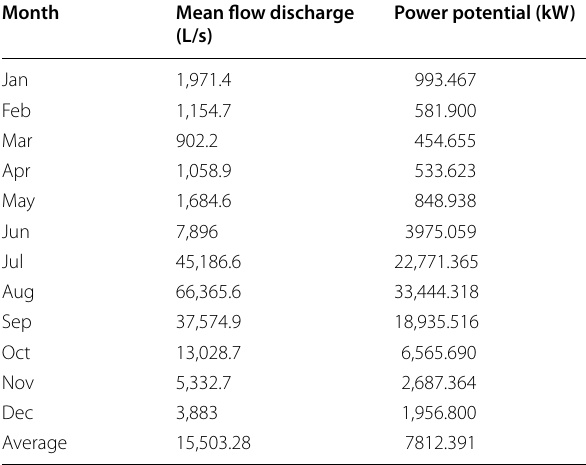
Table 5 Average mean flow discharge and power potential of the Ribb River (Quigley